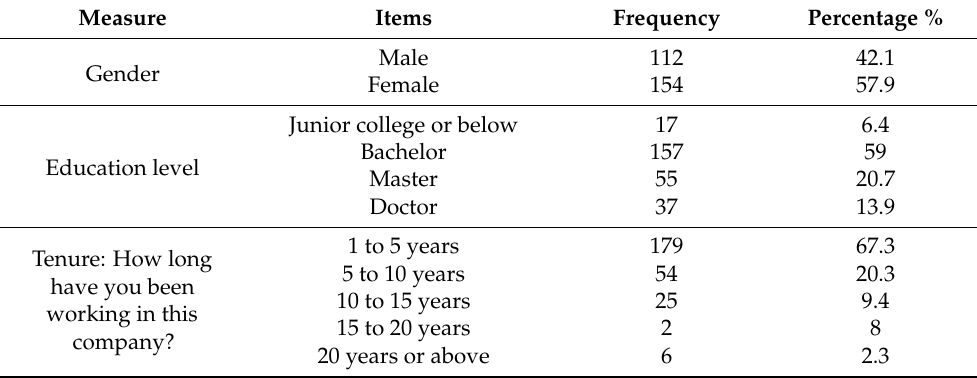
Table 1. Demographic profile of